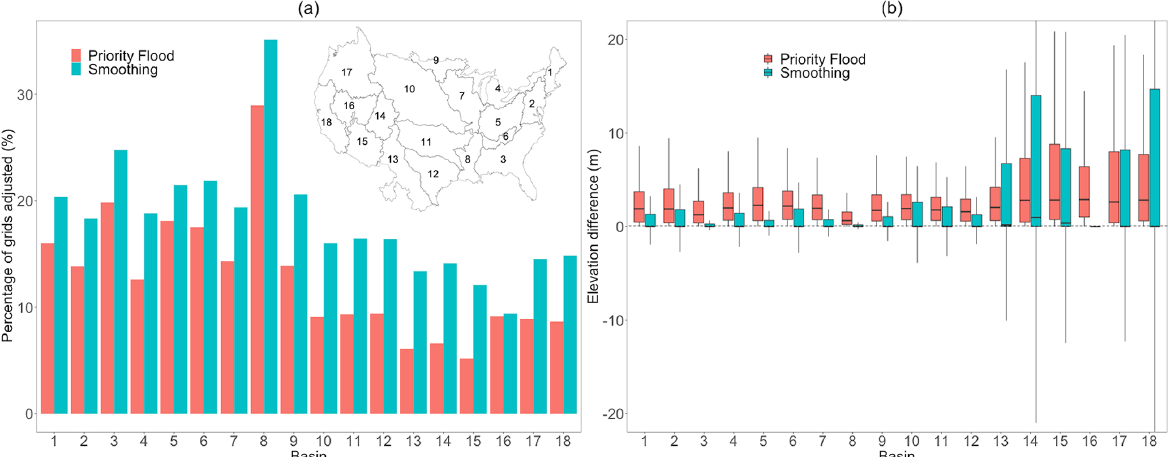
Figure 12. (a) The percentage of grids processed in two processing parts in HUC2 basins; (b) the elevation difference after the two processing